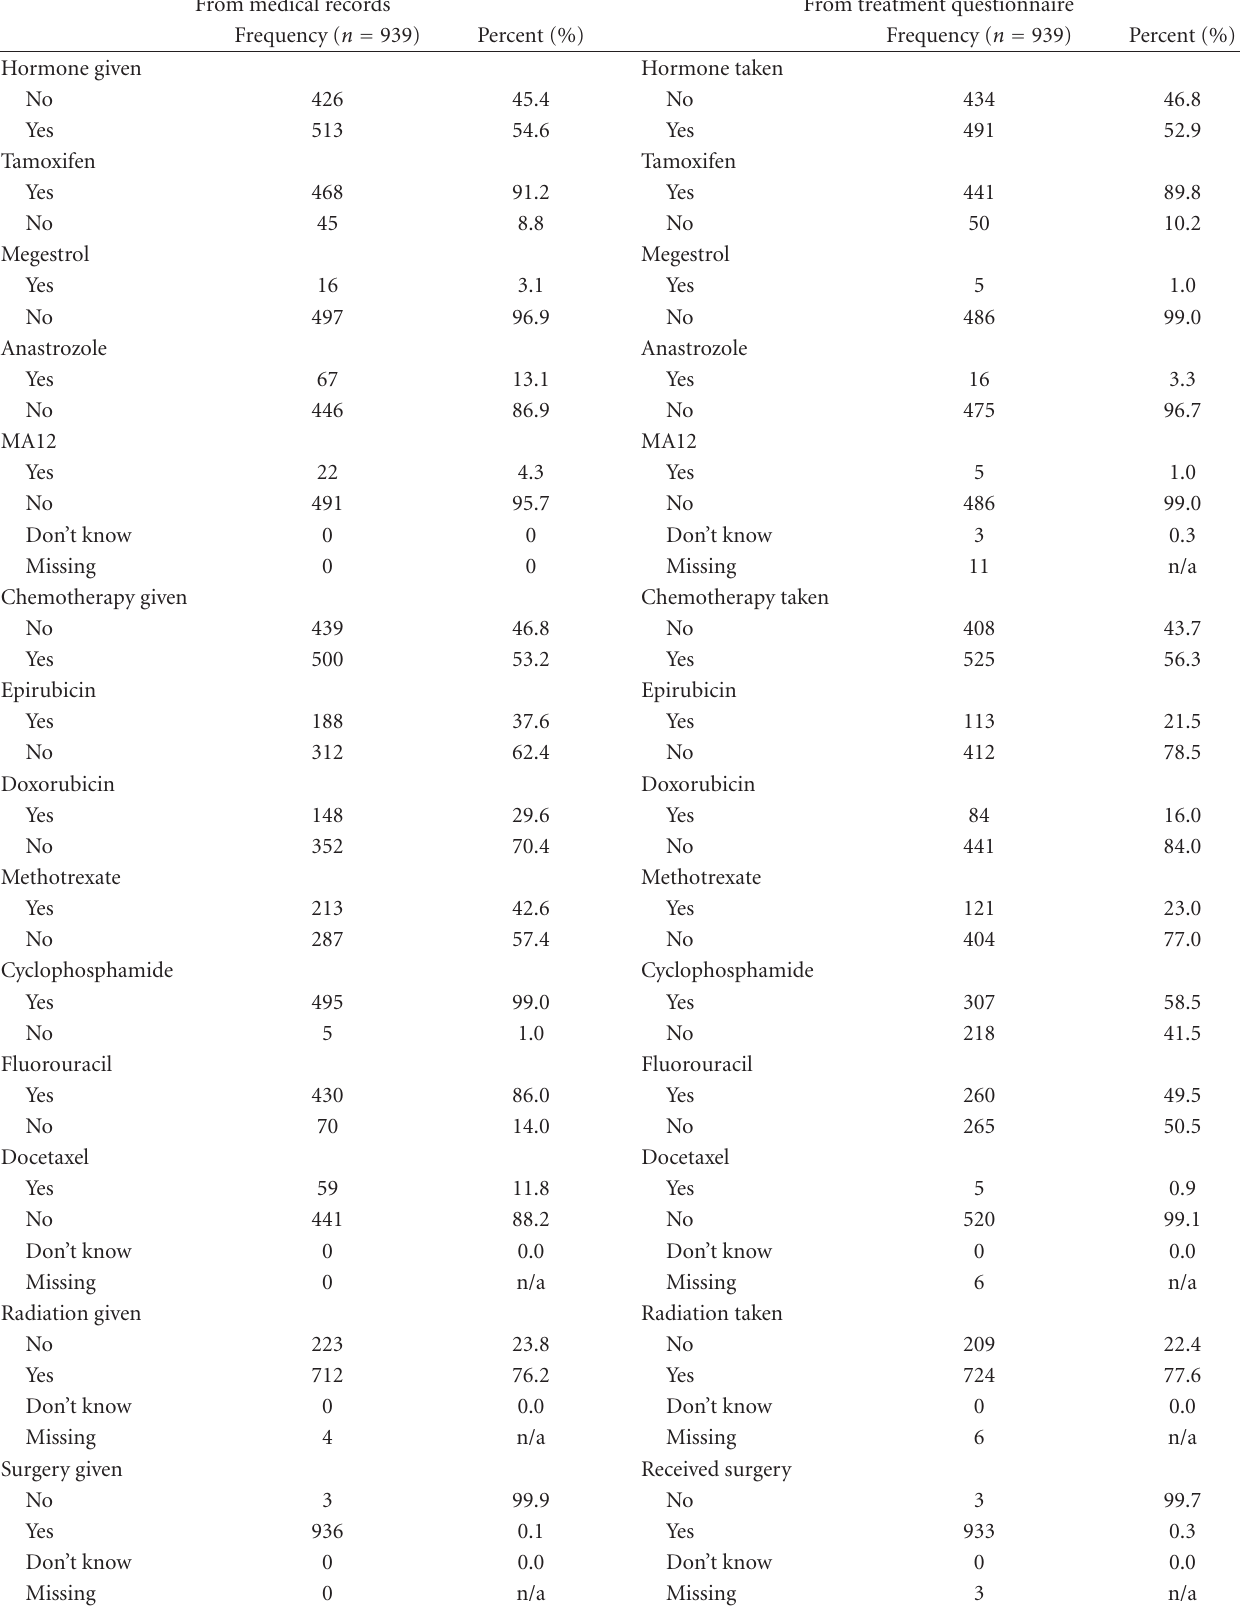
Table 2: Comparison of treatment, recurrence, and menopausal information obtained from medical records and self-administered questionnaire in women with breast